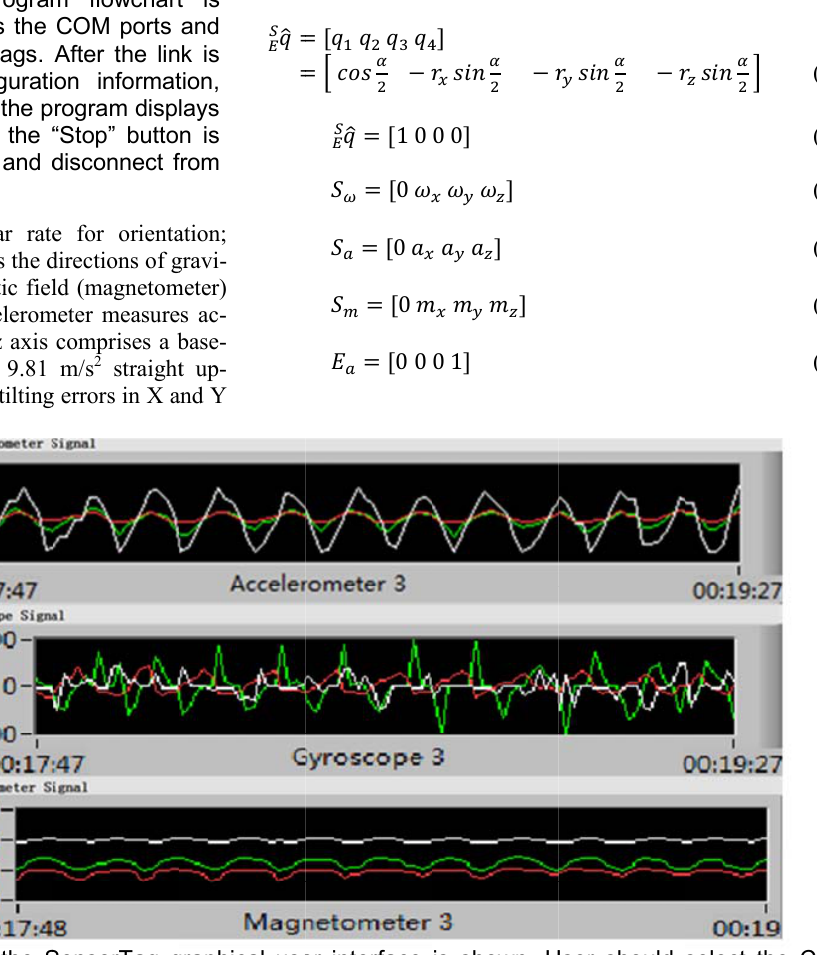
Figure 6. T port(s) first, the